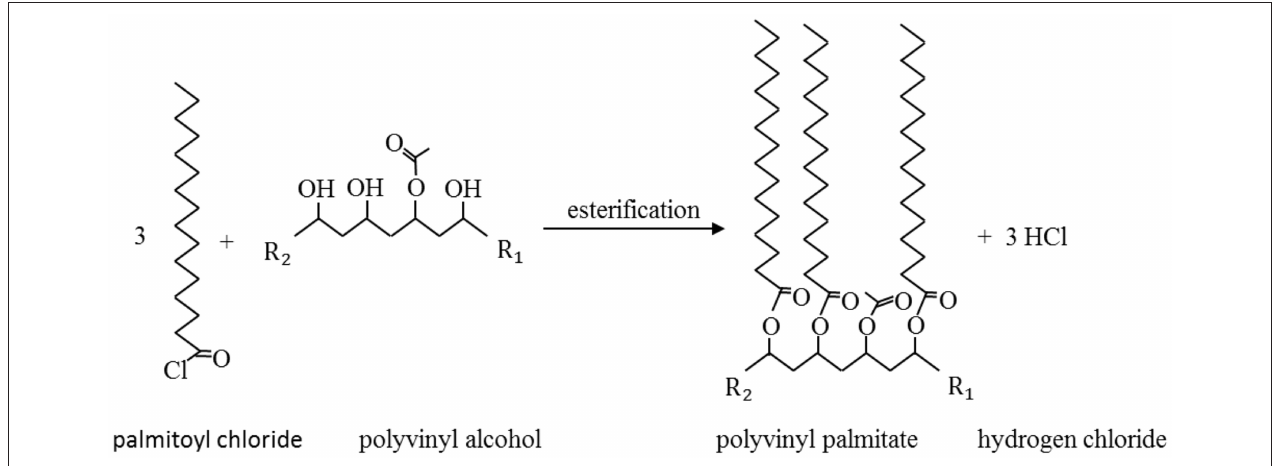
FIGURE 1 | Esterification of palmitoyl chloride and polyvinyl alcohol. R 1 and R 2 illustrate the continuation of PVOH chain. Adapted from Haas et al. (2017).